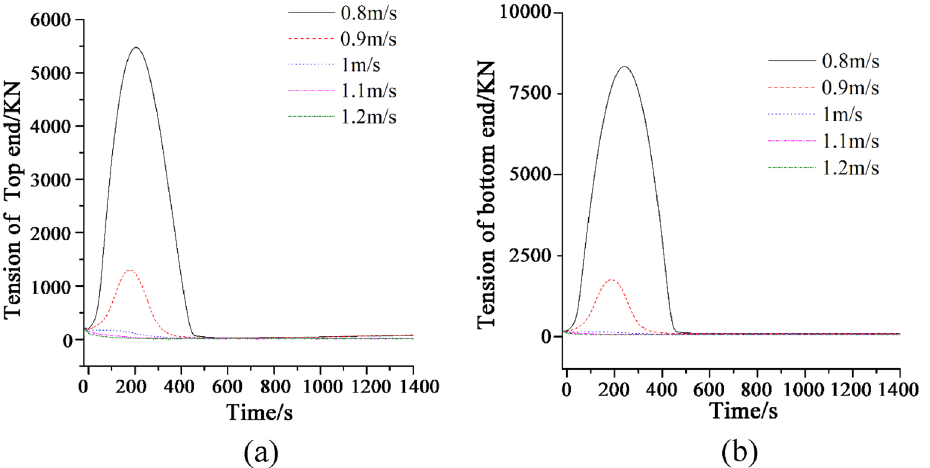
Figure 4. ( a ) Tension of the marine cable at top end at different release rates; ( b ) Tension of the marine cable at bottom end at different release